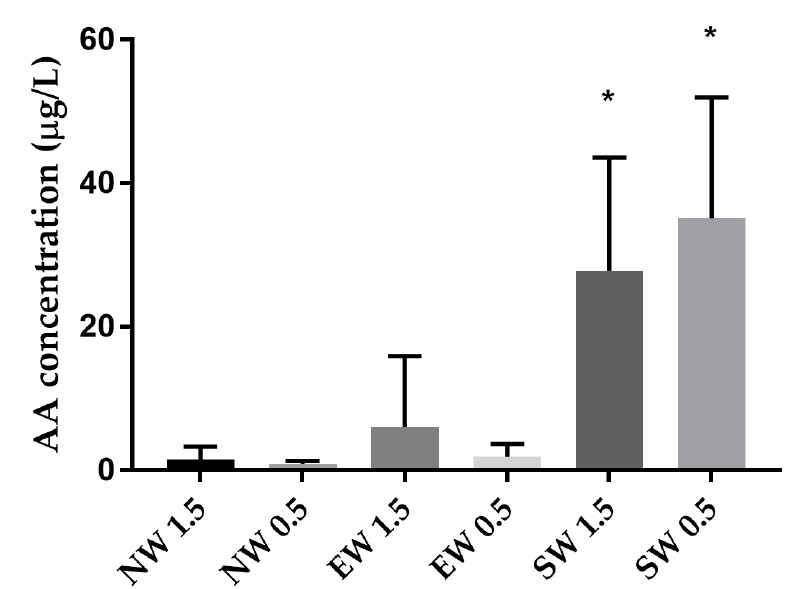
Figure 2. Acetaldehyde (AA) concentrations (mean ± standard deviation) for each group of water. * Significantly different from the other groups (Kruskal–Wallis one-way analysis of variance and Dunn’s multiple comparison post-hoc test, P < 0.05). NW1.5 = natural still water 1.5 L, n = 25; NW0.5 = natural still water